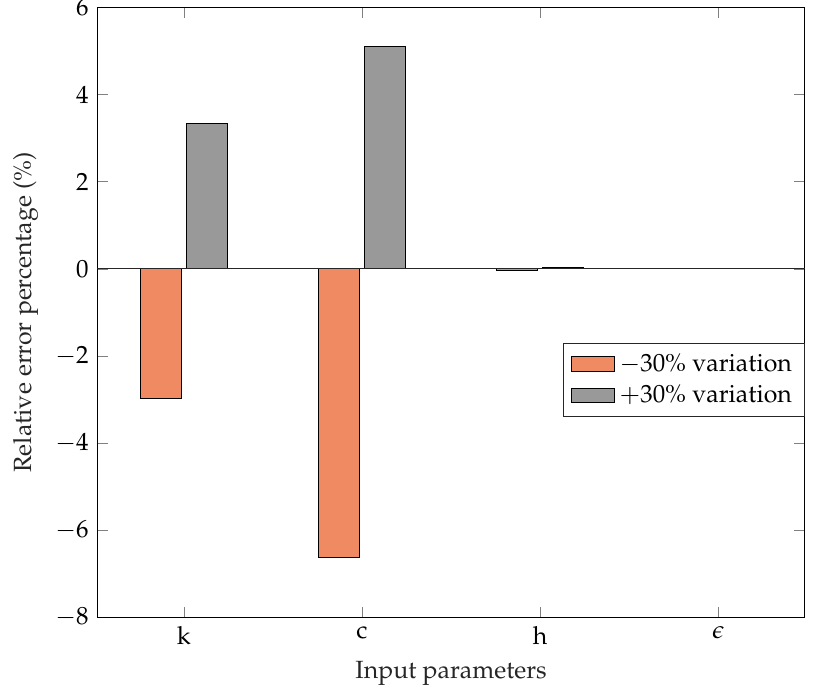
Figure 12. Relative error percentage with respect to the maximum temperature of the reference